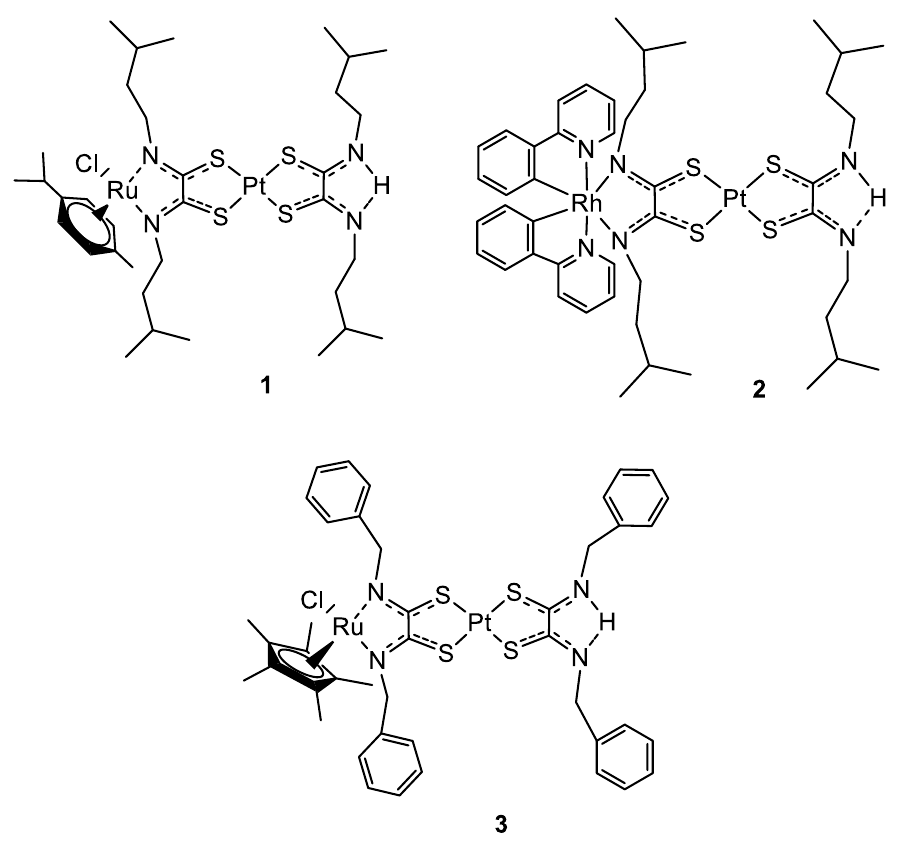
Figure 1. Molecular structure of compounds 1 – 3 .